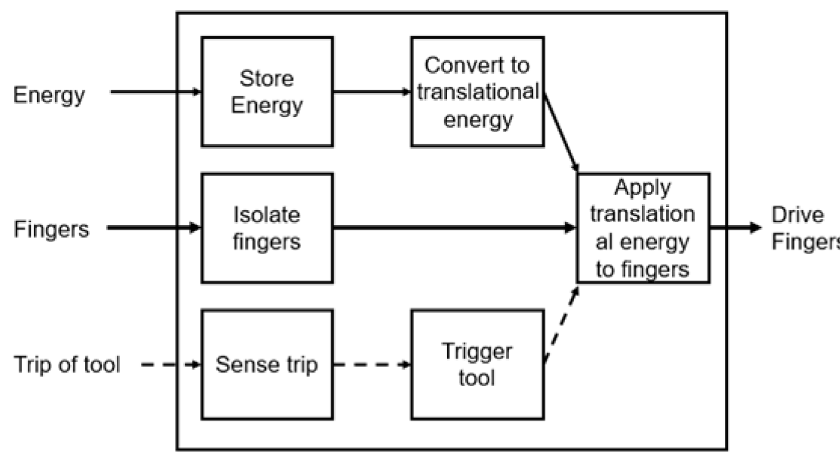
Figure 13. Functional decomposition diagram with subfunctions.